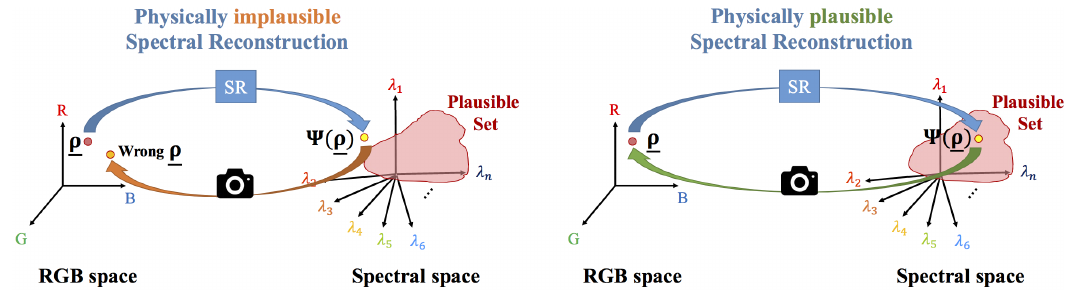
Figure 6. Physically implausible ( left ) and physically plausible spectral reconstruction ( right